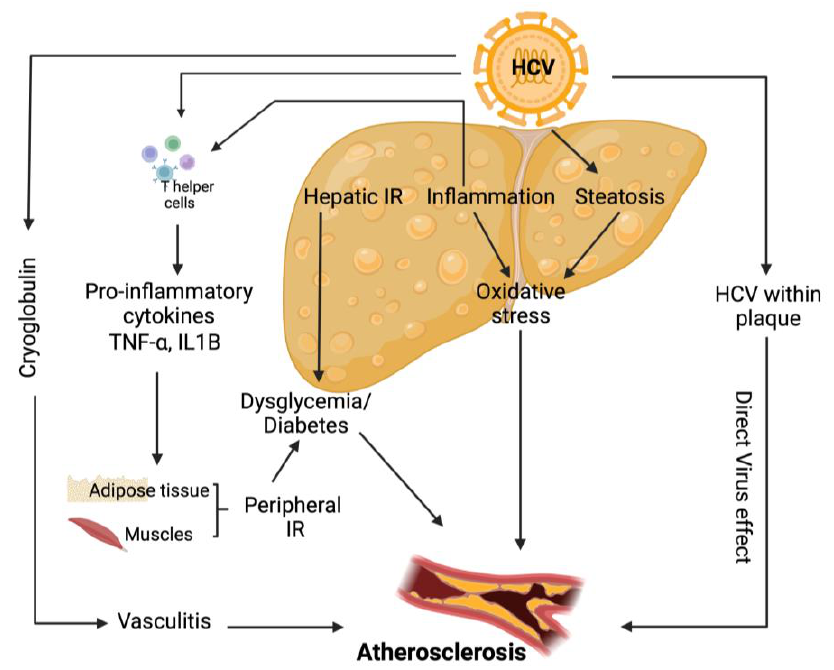
Figure 4. Direct and indirect pathogenic mechanisms responsible for the development of atheroscle- rosis in chronic hepatitis C infection. HCV: Hepatitis C virus; IR: Insulin resistance; TNF- α : Tumor necrosis factor- α ; IL1B: interleukin-B1.